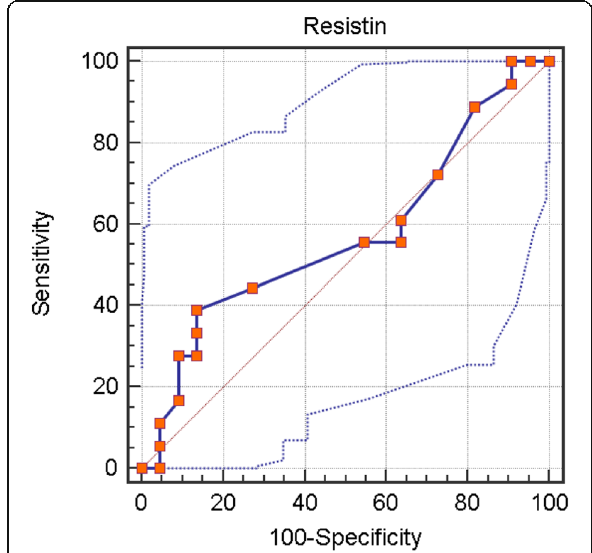
Fig. 1 ROC Curve of serum resistin level in prediction of liver cirrhosis based on FIB4 score in both studied groups of